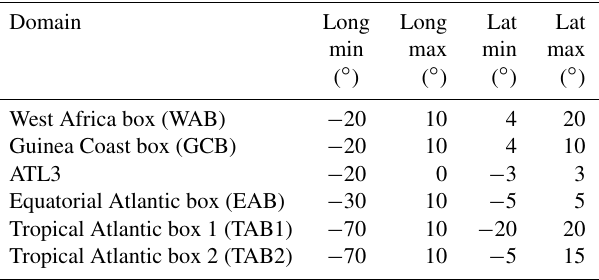
Table 2. Coordinates of different